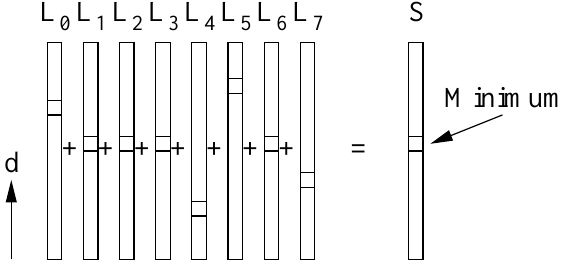
Figure 3: Costs for all disparities of a certain pixel from paths of eight different directions that are summed to S . The minimum of S may differ from the minima of the pathwise costs.